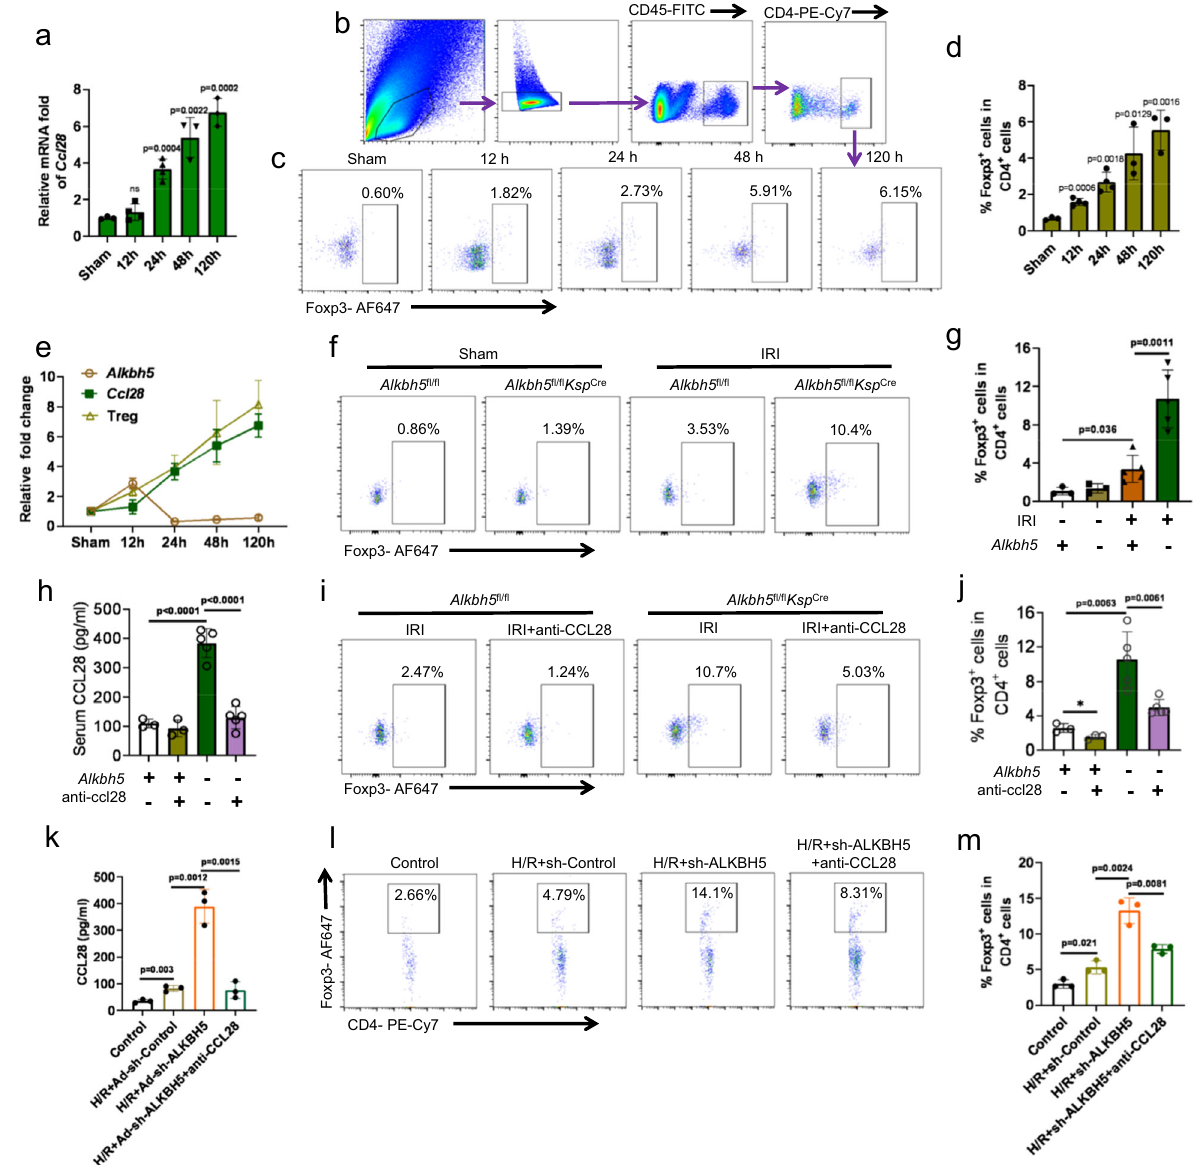
Fig. 6 | A lkbh5 de fi ciency increased the recruitment of Tregs through CCL28. a RNA levelof Ccl28 in different times after I/Rwasexamined by RT-qPCR. n =3,4, 4, 3, 3 biologically independent animals for Sham, 12h, 24h, 48h, and 120h groups, respectively. b The FACS analysis process of Tregs. c , d Representative fl ow cytometry dot plots and percentage of CD4 + Foxp3 + cells among the CD4 + T cells at 0h, 12h, 24h, 48h, and 120h after I/R. n =3, 4, 4, 3, 3 biologically independent animals for Sham, 12h, 24h, 48h, and 120h groups, respectively. e The line chart showed the relationship of ALKBH5, CCL28, and Tregs. f , g Renal recruitment of CD4 + Foxp3 + cells 24h after IRI in 4 groups. n =3 for Sham groups, n =5forIRIgroups.Eachdatapointrepresentsoneanimal. h TheCCL28proteinin serum from IRI- Alkbh5 fl / fl Ksp Cre or IRI- Alkbh5 fl / fl mice with or without